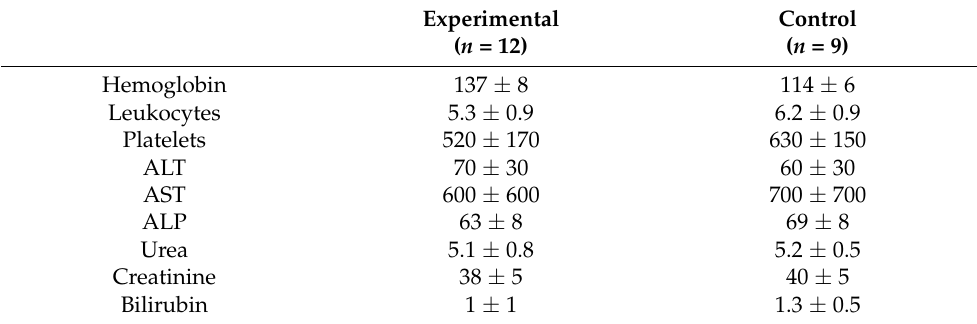
Table 1. Results of blood analysis; t -test, p < 0.05.